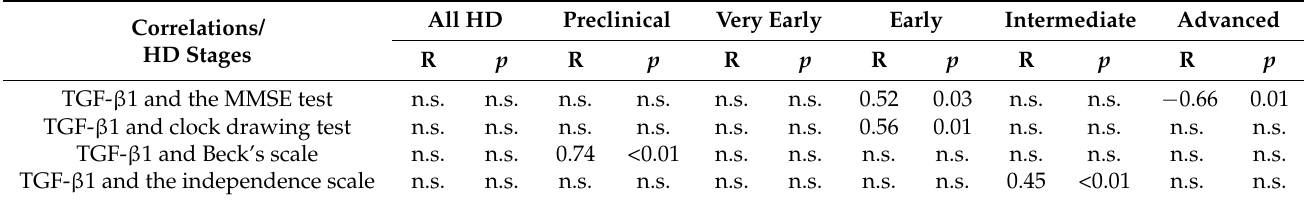
TGF- β 1 and the independence scale